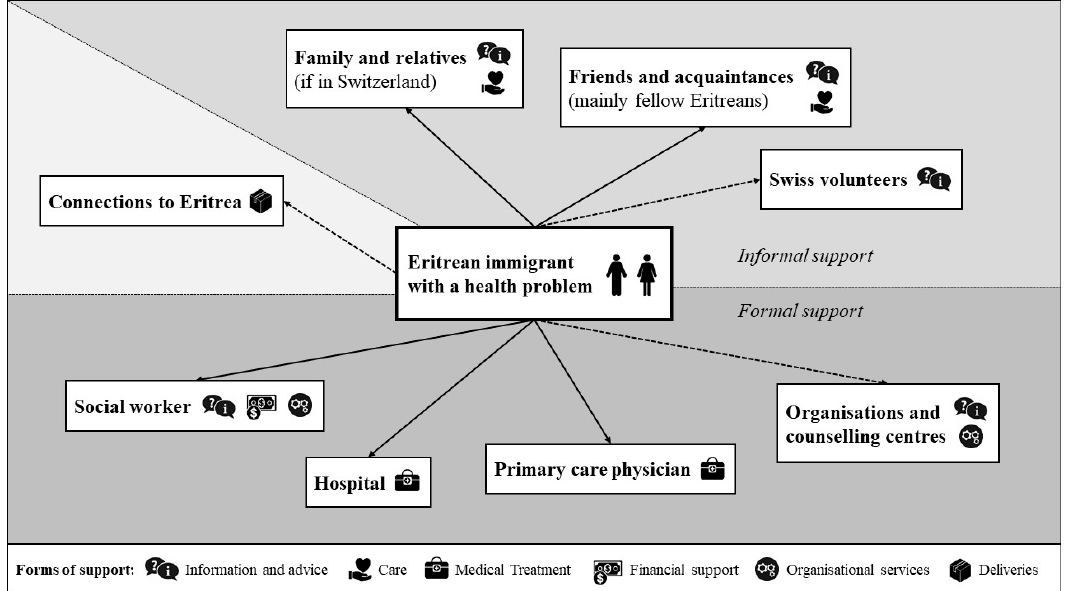
Figure 1. Overview of an Eritrean immigrant’s primary care network (main actors and main support forms). Source: own illustration based upon the interviews.